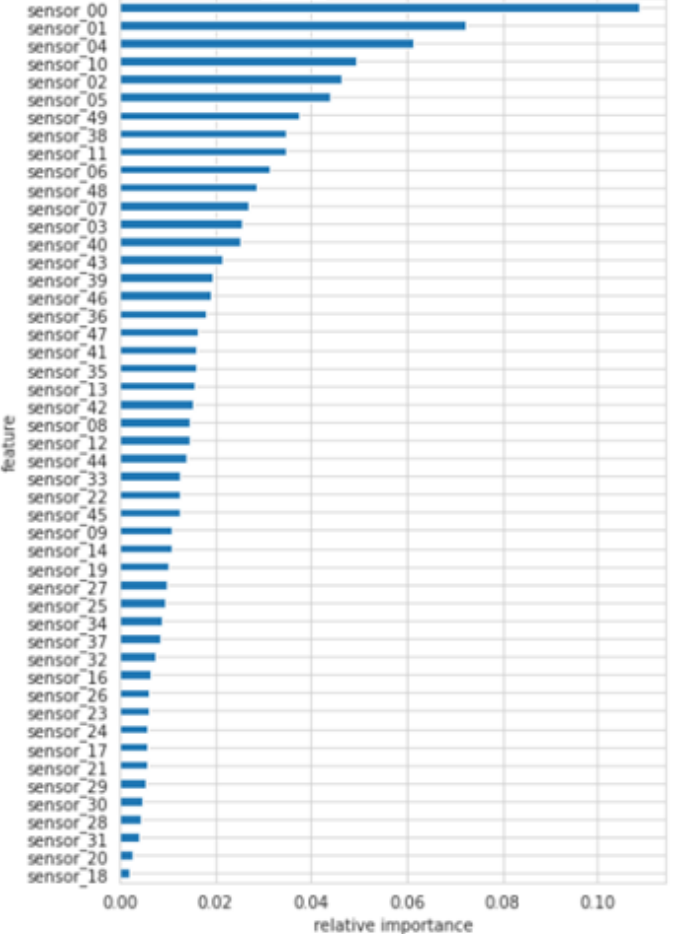
Figure 9. Ranking the features using XGBOOST.